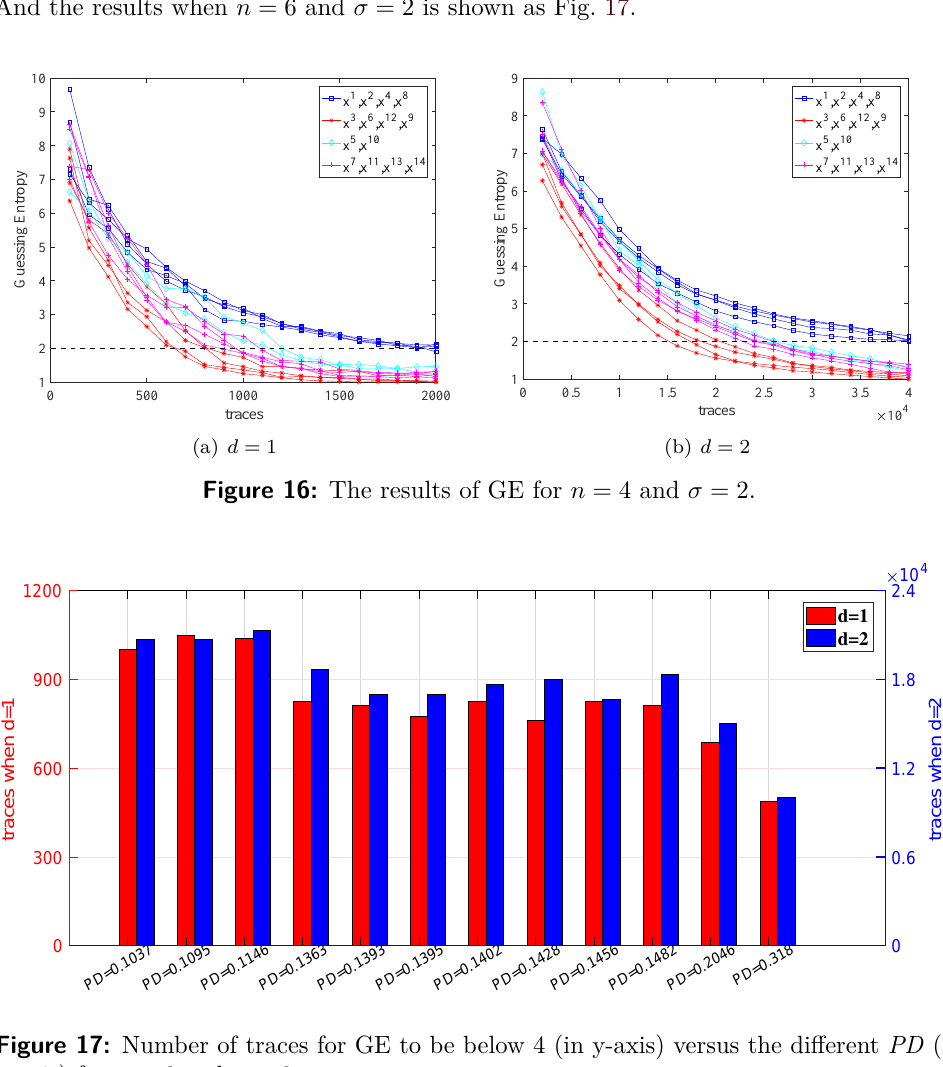
Figure 17: Number of traces for GE to be below 4 (in y-axis) versus the different PD (in x-axis) for n = 6 and σ =